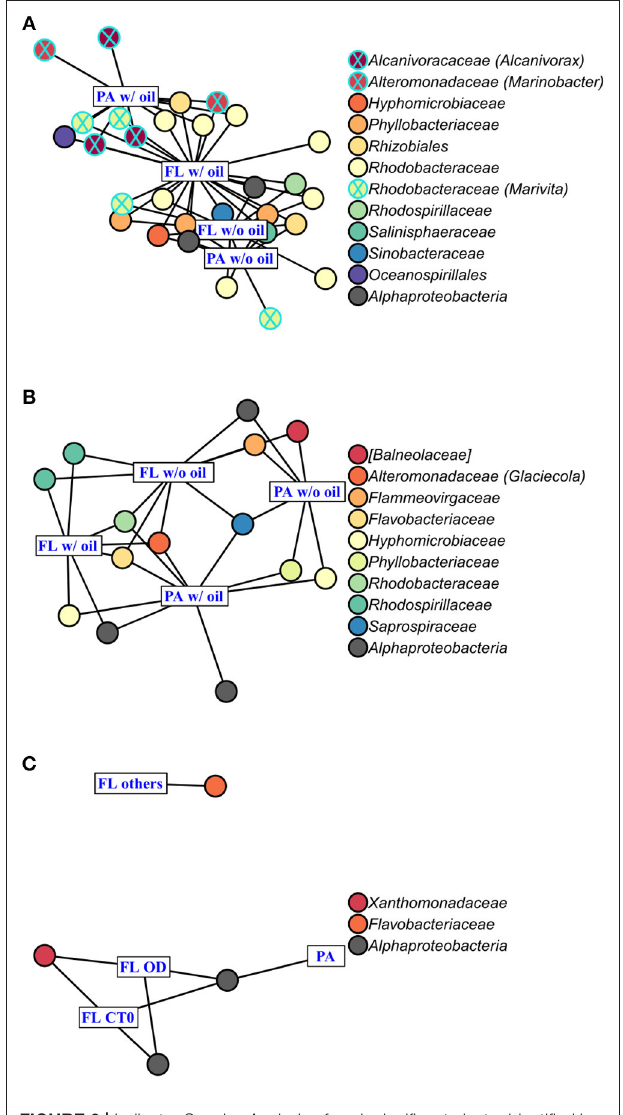
FIGURE 6 | Indicator Species Analysis of each significant cluster identified by PCoA ( Figure 4 ) and ANOSIM, for (A) A. carterae , (B) P. sociale , and (C) Skeletonema sp. microbiomes. Rectangles represent the treatment clusters annotated in blue, where “FL others” in (C) includes the CTf, D and O treatments. Circles are the significant indicator OTUs (see Table S2 for the detailed Indicator Species Analysis results), the fill colors show OTU taxonomy at the family level with the genus into bracket when assigned. Known oil-degrading OTUs are circled in blue, and non-oil-degrading OTUs are circled in